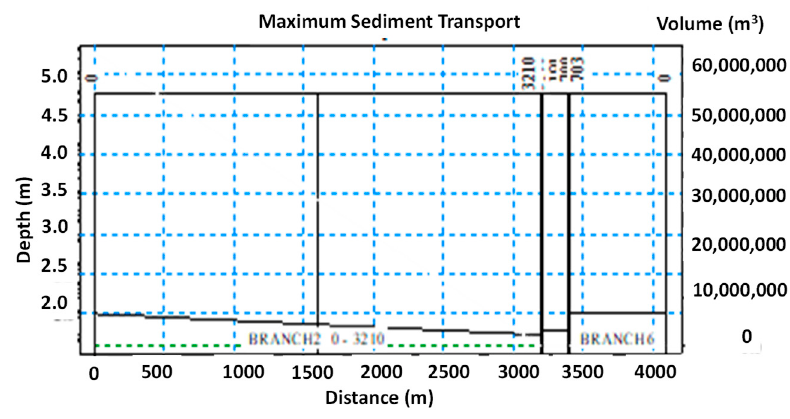
Figure 11. Movement of sediment in the tc-1 tertiary channel has a sluicegate